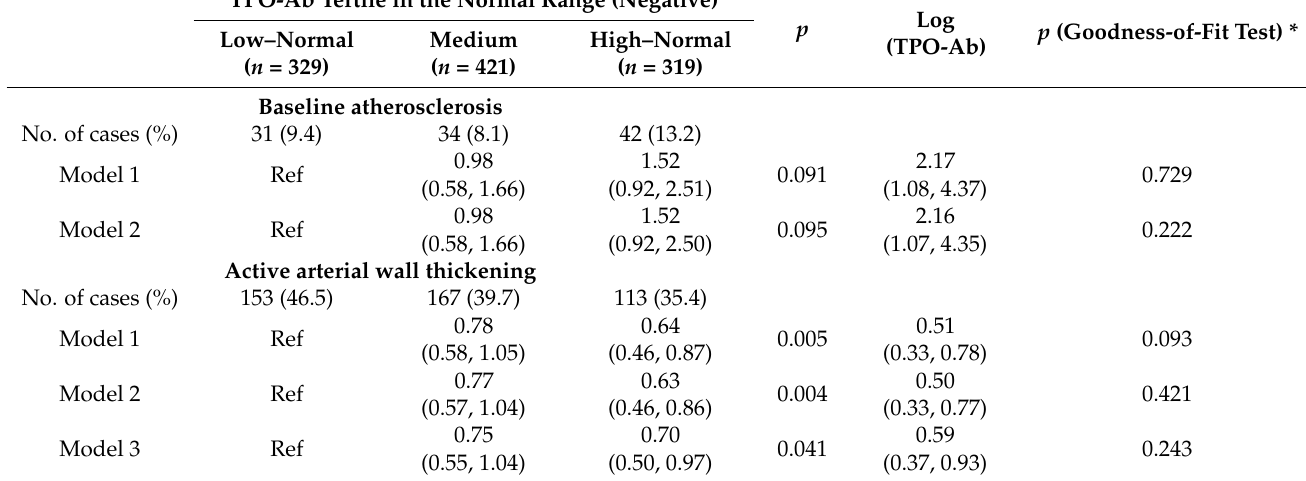
Table 3. Odds ratios (ORs) and 95% confidence intervals (CIs) of anti-thyroid peroxidase anti- body (TPO-Ab) titer in the normal range (negative) for baseline atherosclerosis and active arterial wall